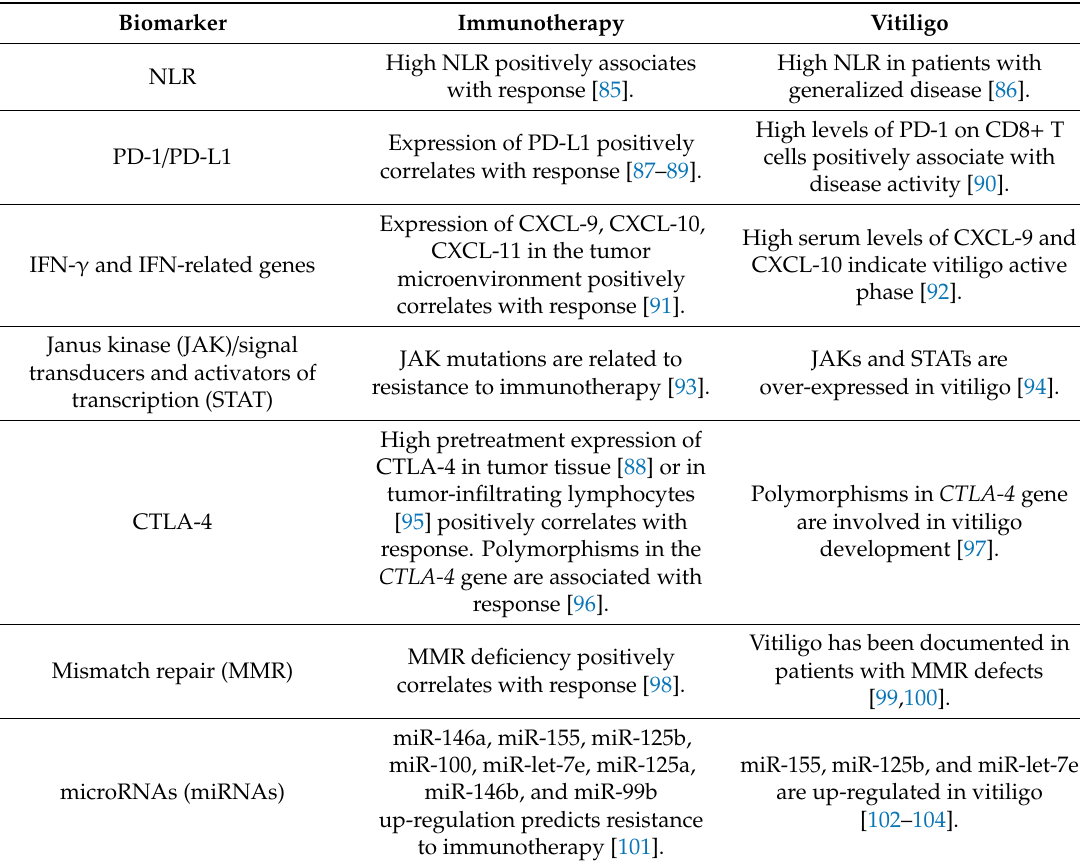
Table 1. Biomarkers of response to check-point inhibitor immunotherapy that are also associated with vitiligo